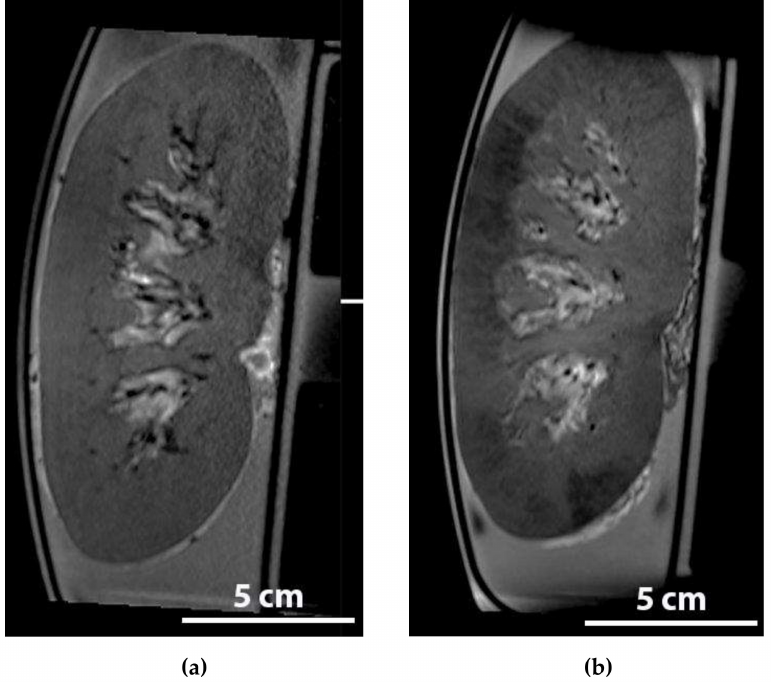
Figure 5. Anatomical, T2 weighted MRI sequence of a whole porcine kidney during normothermic ex vivo perfusion, in which water is typically displayed as white and iron (particles) will display as black. Examples of coronal reconstructions ( a ) baseline; ( b ) shortly after the infusion of 1 million FeraTrack labelled MSCs. The dark areas in the renal cortex represent the